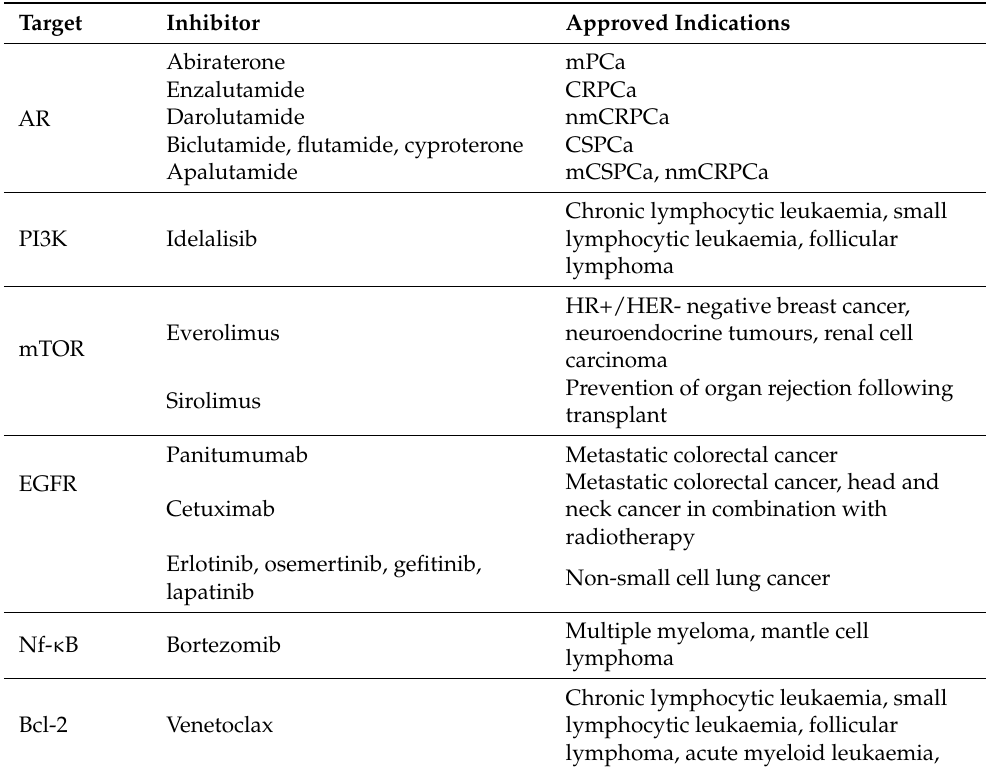
Table 1. Therapeutic Goods Administration (TGA) approved inhibitors of biological mechanisms that promote radioresistance in PCa. (mPCa = Metastaic PCa; CRPCa = castrate resistant PCa; nmCRPCa = non-metastatic castrate resistant PCa; CSPCa = castrate sensitive PCa; mCSPCa = metastatic castrate sensitive